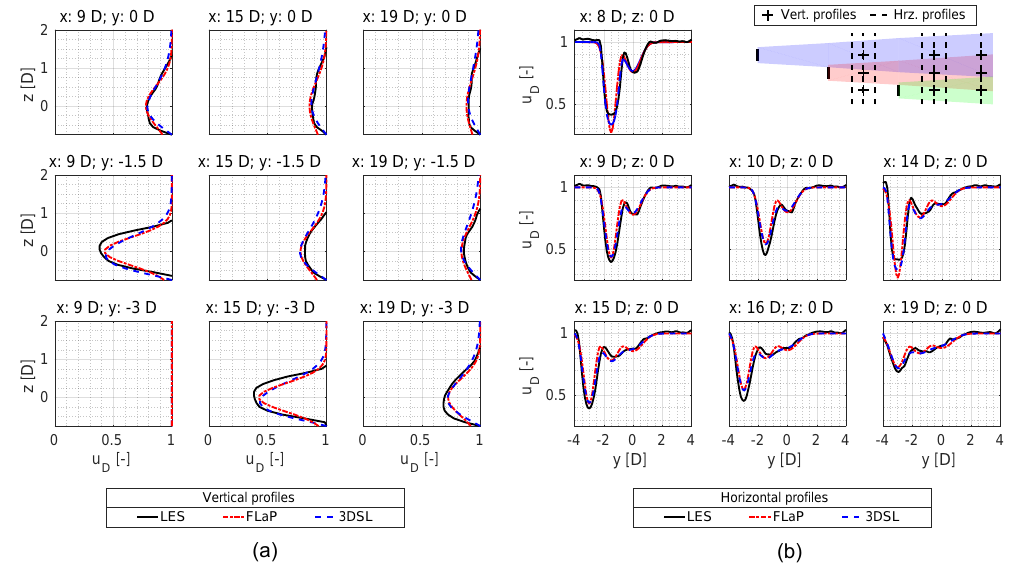
Figure A4. Test case 4 (multiple wakes with 1.5 D lateral separa- tion). Downstream development of the vertical (a) and horizontal (b) profiles of the wake velocity evaluated along the common axis of the wind turbines from the 3DSL model and FLaP simulations and from the reference large-eddy simulation (LES) wind field. The position of the profiles considered is illustrated in the top right cor- ner of (b)